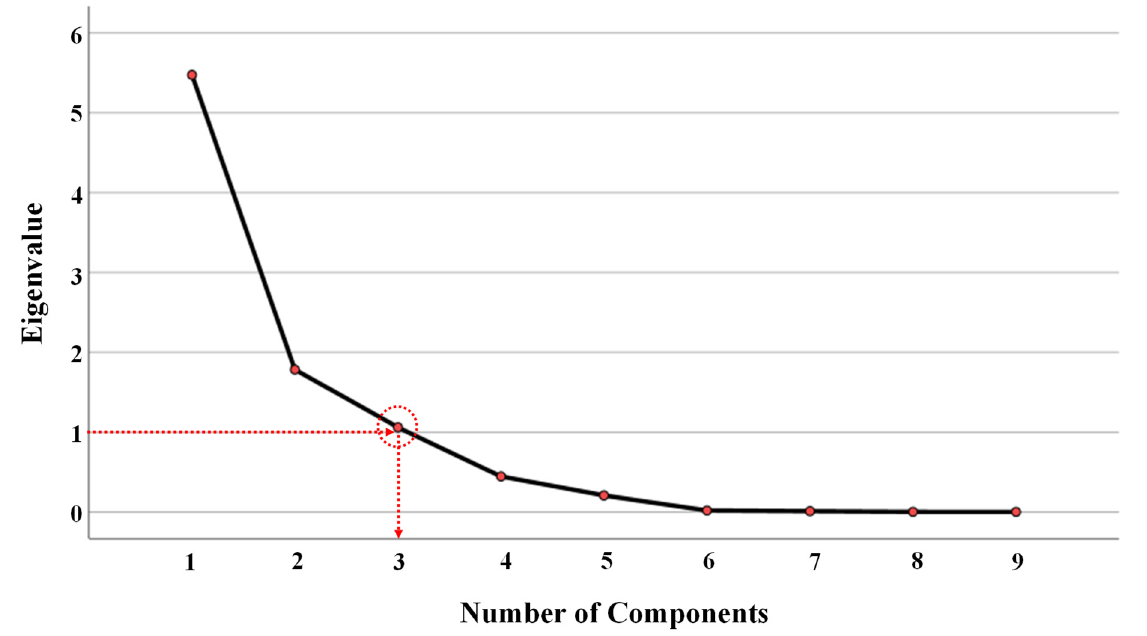
Figure 4. Principal component analysis method for factor prediction. The red arrow indicates the number of components corresponding to the Eigenvalue equal to 1.